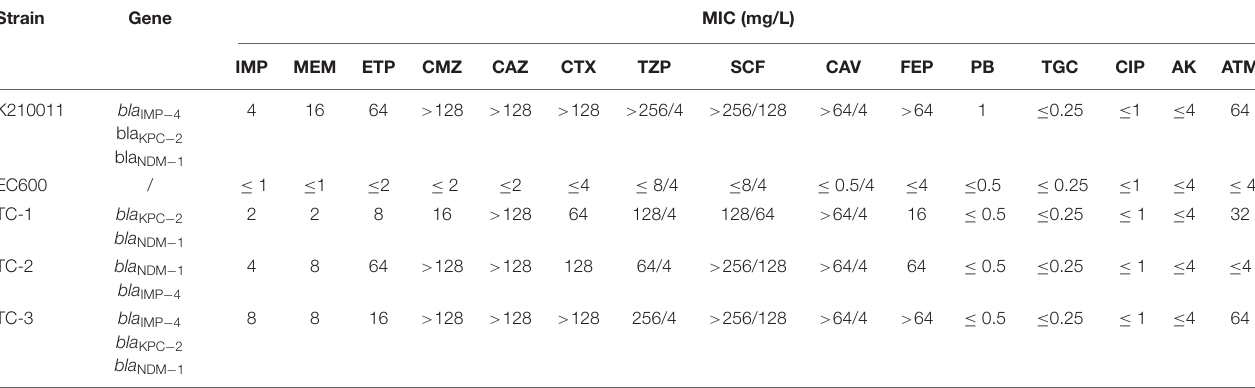
TABLE 1 | Characteristics of K210011 and corresponding transconjugants.